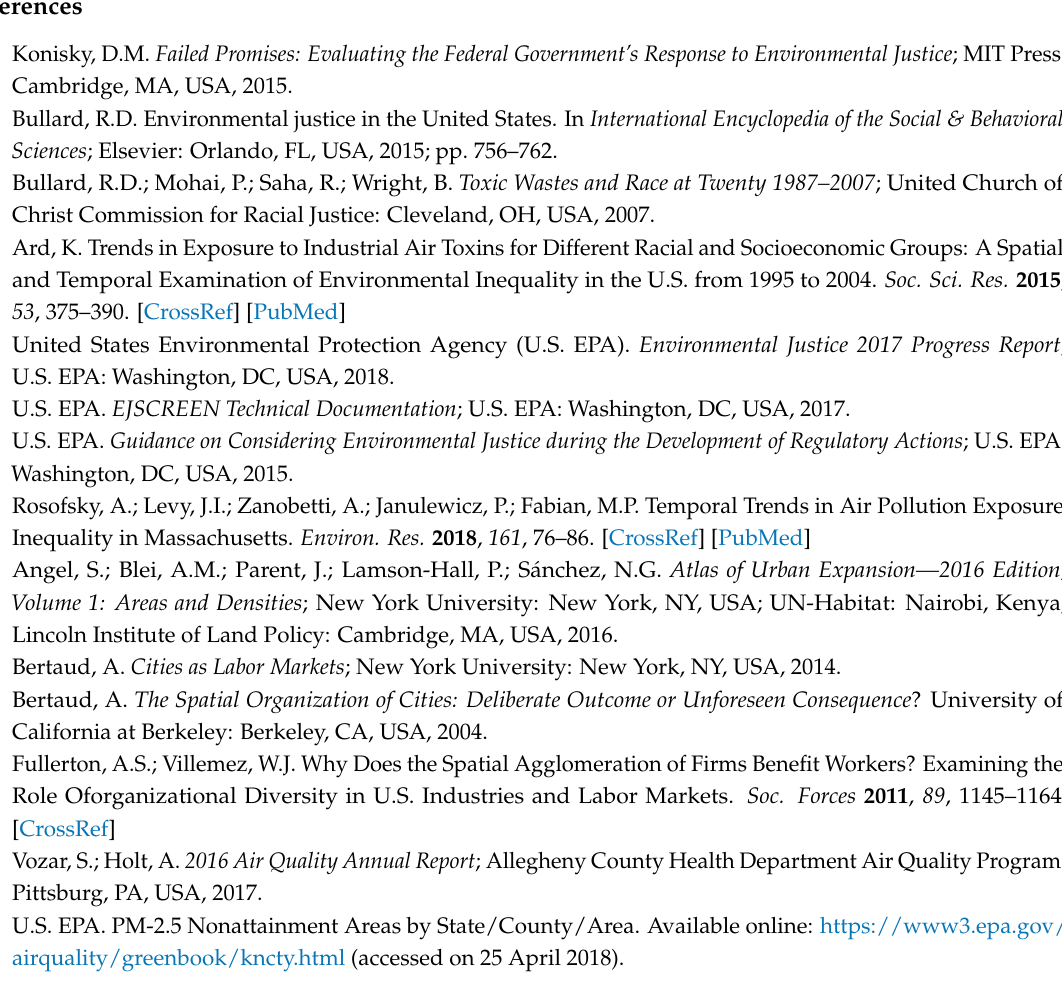
s1, Table S1: Primary block groups identified by EJSCREEN as environmental justice priority areas, Table S2: Secondary block groups identified by EJSCREEN as environmental justice priority areas, Table S3: Primary block groups identified in the present study as environmental justice priority areas, Table S4: Secondary block groups identified in the present study as environmental justice priority